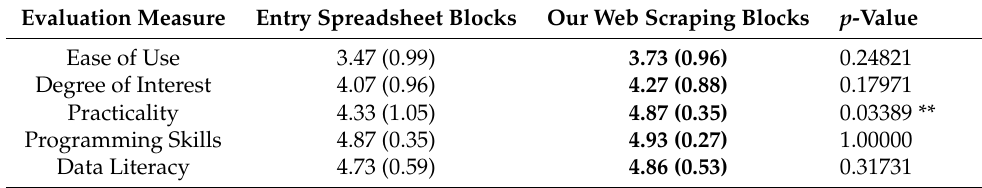
Figure 9. Summary of the teachers’ programming and educational experience. Table 1. Experimental results comparing the Entry spreadsheet blocks and our web scraping blocks for the five evaluation measures. Numbers outside parentheses represent means, and numbers inside parentheses represent standard